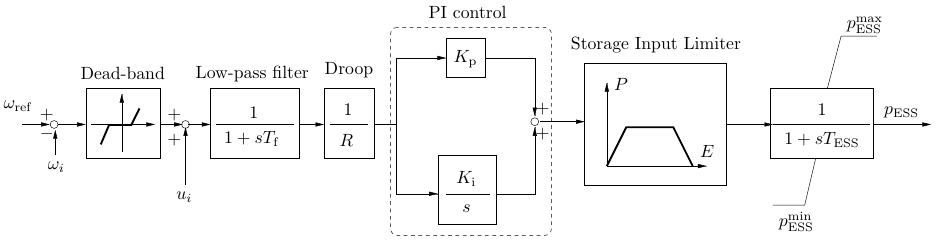
Figure 2. Frequency controller of the ESS.